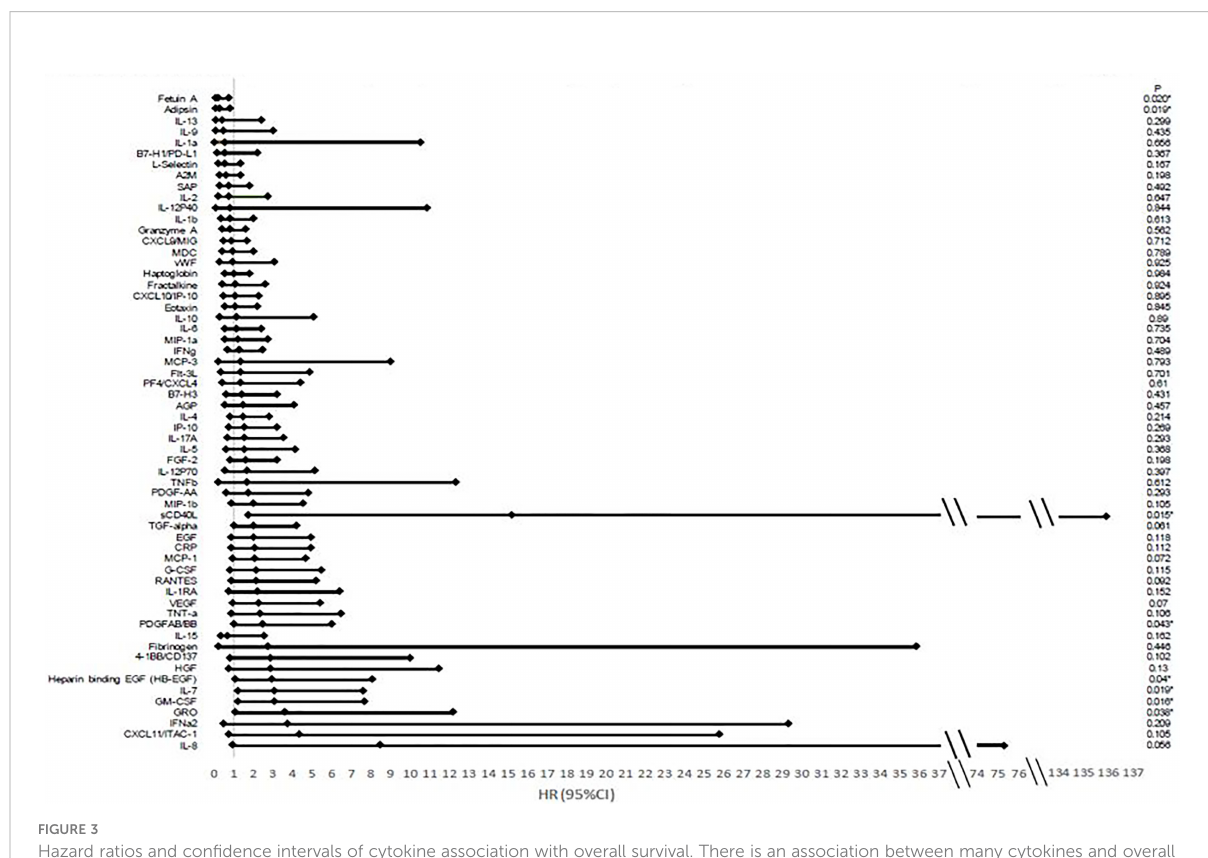
FIGURE 3 Hazard ratios and con fi dence intervals of cytokine association with overall survival. There is an association between many cytokines and overall survival based on analysis looking at cytokines as a continuous variable based on Luminex multiplex bead array assays. Hazard ratios (HRs) correspond to a standard deviation change in the